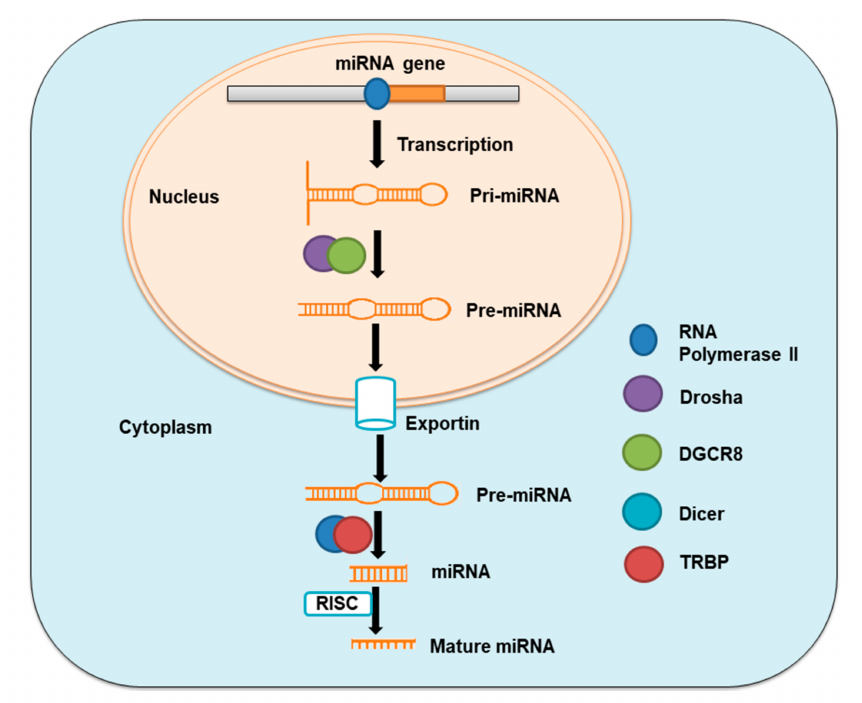
Figure 1. Schematic of miRNA